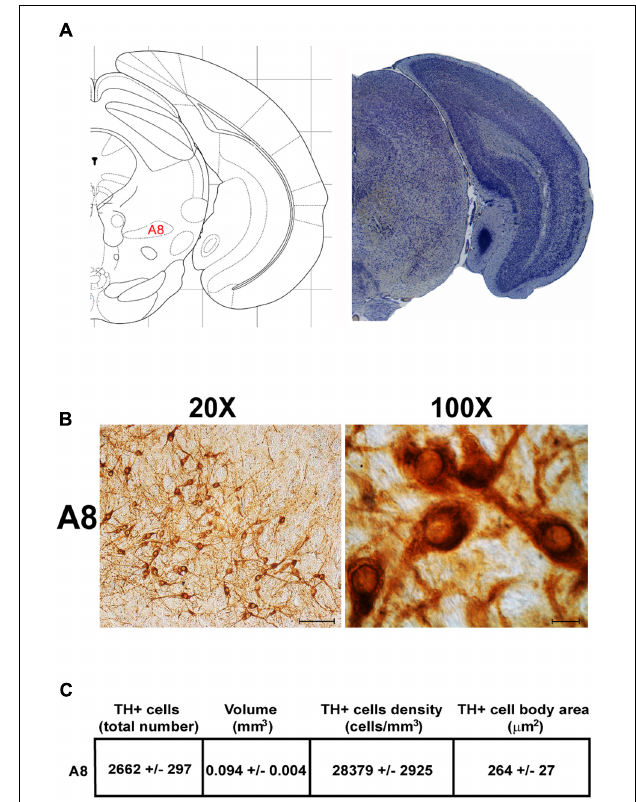
FIGURE 4 | Anatomical and morphometric analyses of TH-positive cell of the A8 catecholaminergic nucleus. (A) Nissl staining of the mouse brain at the Bregma level –3.96 (Paxinos and Franklin, 2001) showing the anatomical localization of the A8. (B) Representative images at higher magnification (20 and 100X) of TH immunoreactive cells of the A8. Scale bar: 100 µ m for 20X and 10 µ m for 100X. The corresponding morphometric analyses are shown in (C) . Values are means ±